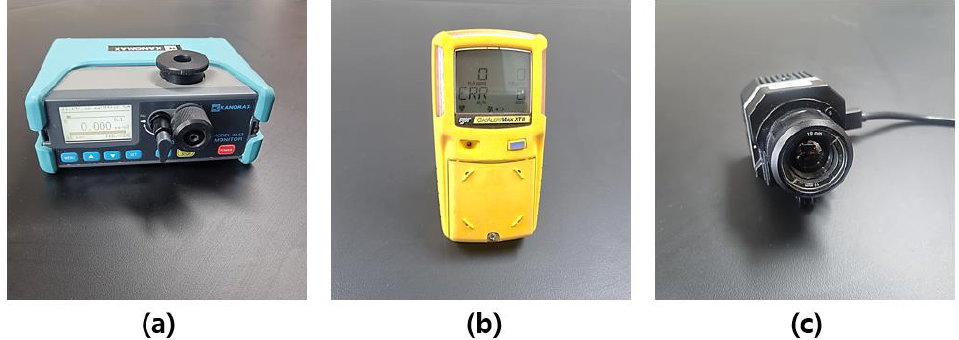
Figure 6. Environmental sensors used in this study: ( a ) particle sensor; ( b ) gas sensor; ( c ) thermal camera. Table 3. Specifications of environmental sensors used in this study.